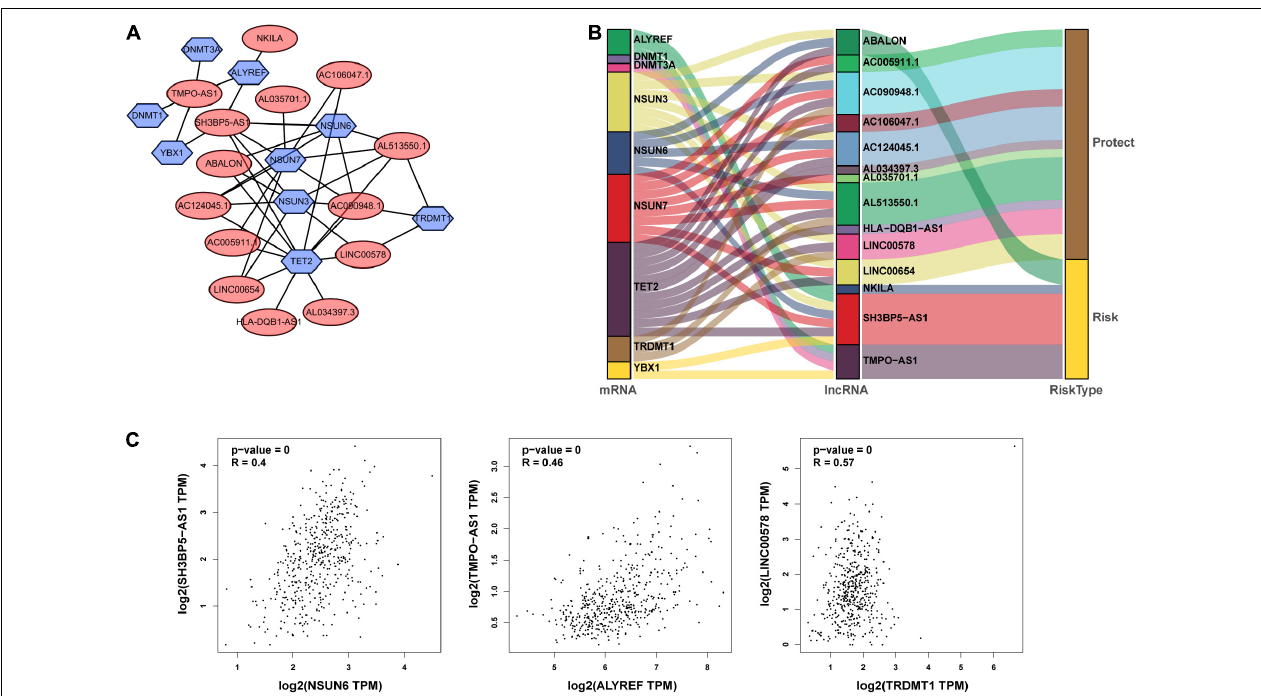
FIGURE 2 | Identification of m5C-associated lncRNAs with significant prognostic value in LUAD. (A,B) Coexpression network of m5C-related lncRNAs–mRNAs. (C) Expression intensity of related genes in the coexpression network analyzed using the Gene Expression Profiling Interactive Analysis (GEPIA) online